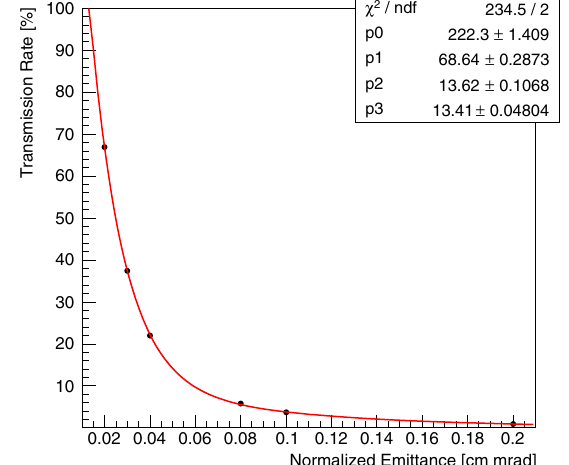
FIG. 18. Deuteron beam transmission rate as a function of normalized emittance. The horizontal and vertical axes represent the normalized emittance assumed in the simulation and the deuteron beam transmission rate through LEBT was evaluated by RFQGen simulation. The red curve depicts the fitting result with a function of f ð x Þ ¼ p 0 exp ð − p 1 x Þ þ p 2 exp ð − p 3 x Þ .